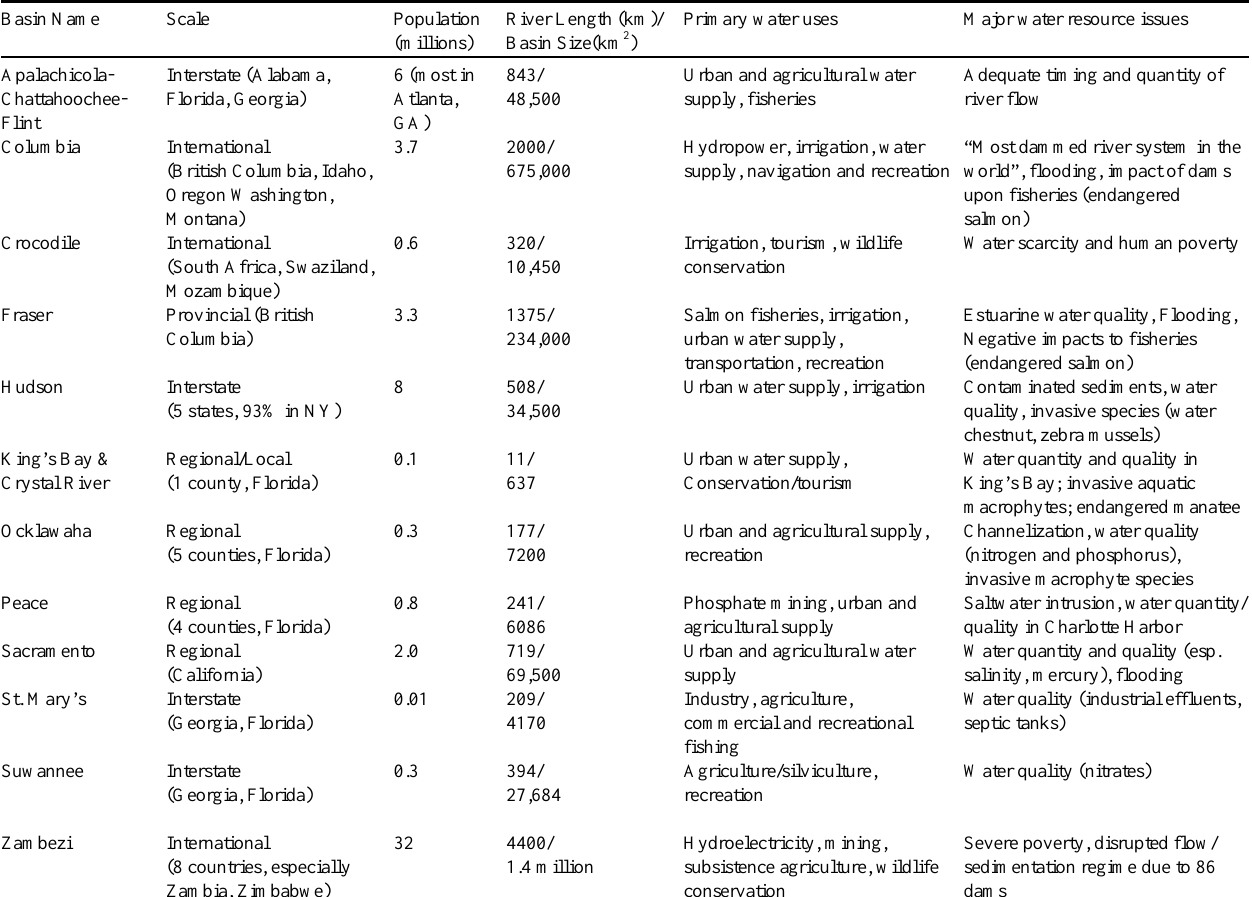
Table 2 . General characteristics of the twelve watersheds considered in this